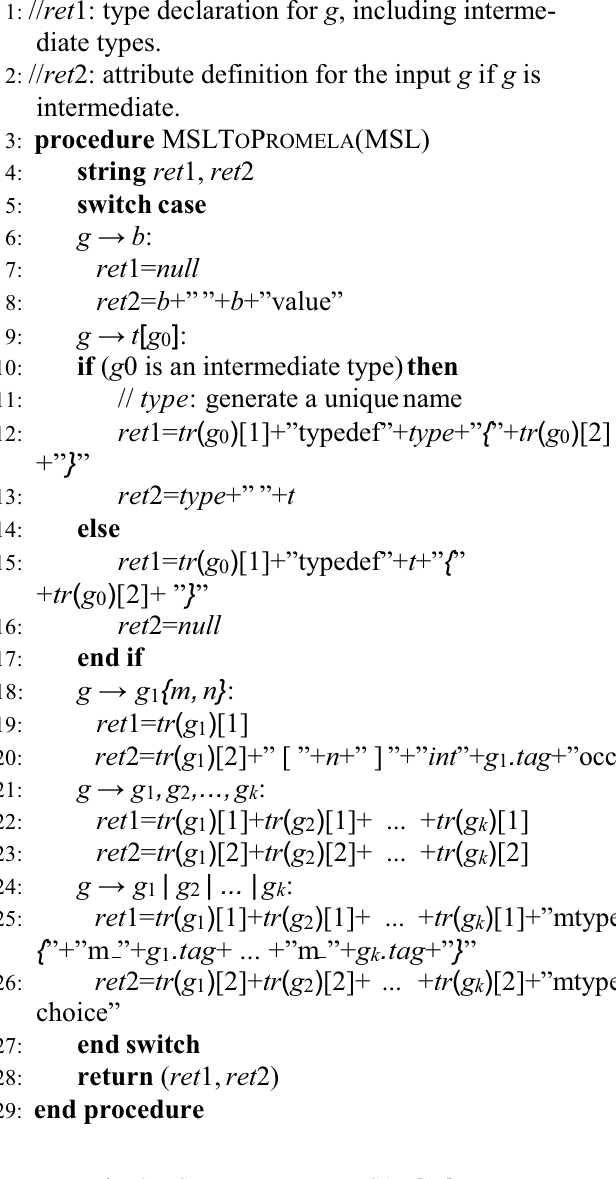
Fig. 6. MSL to P ROMELA - WSAT